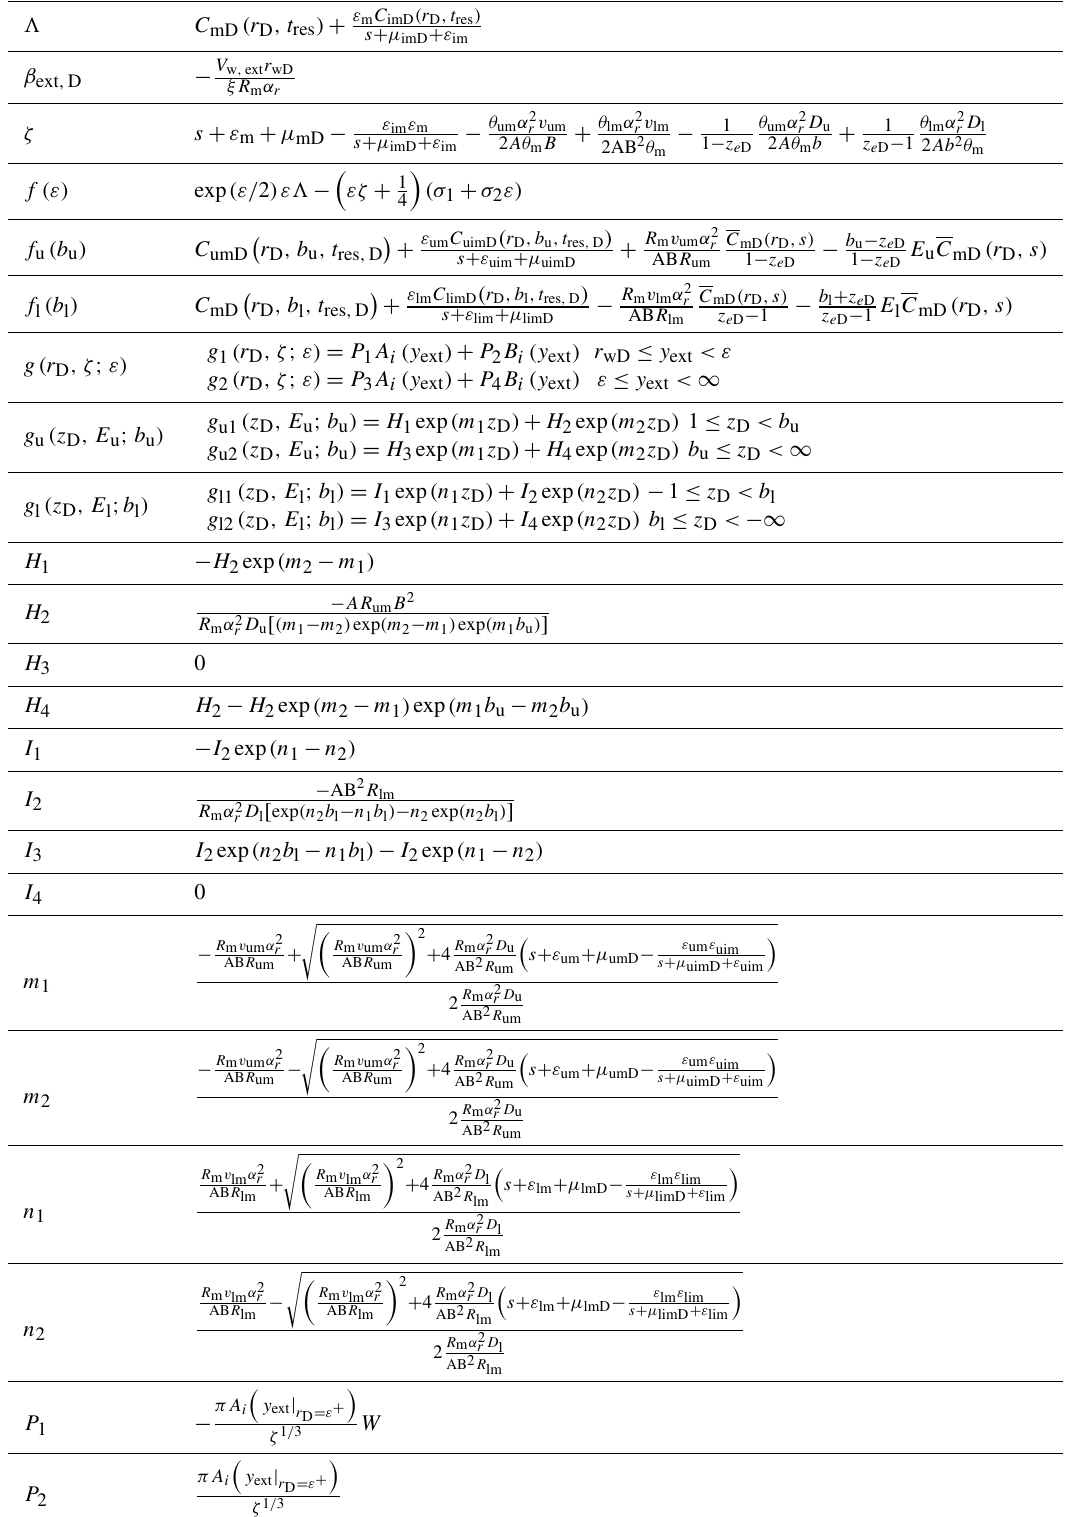
Table 3. Expressions of the coefficients in the solutions expressed in Eqs. (28a)–(28g).